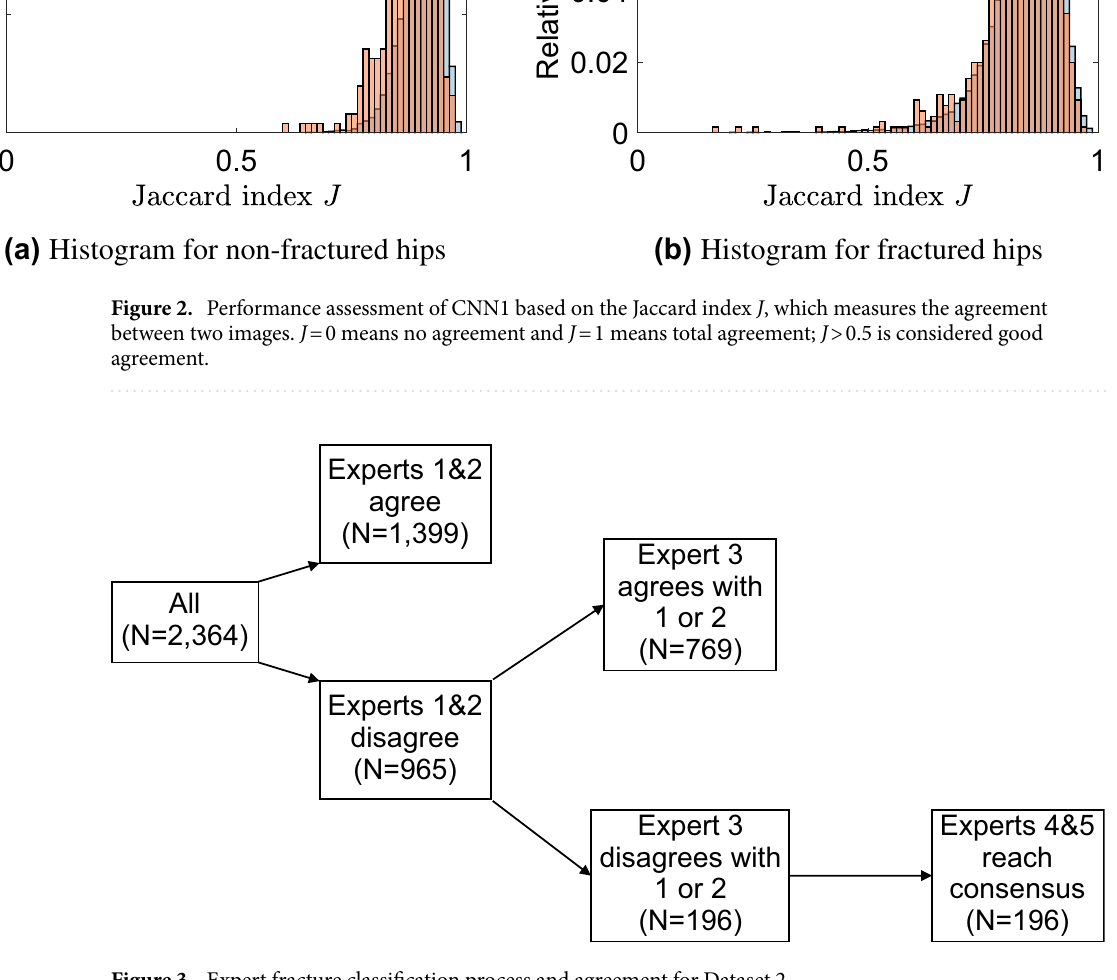
Figure 3. Expert fracture classification process and agreement for Dataset